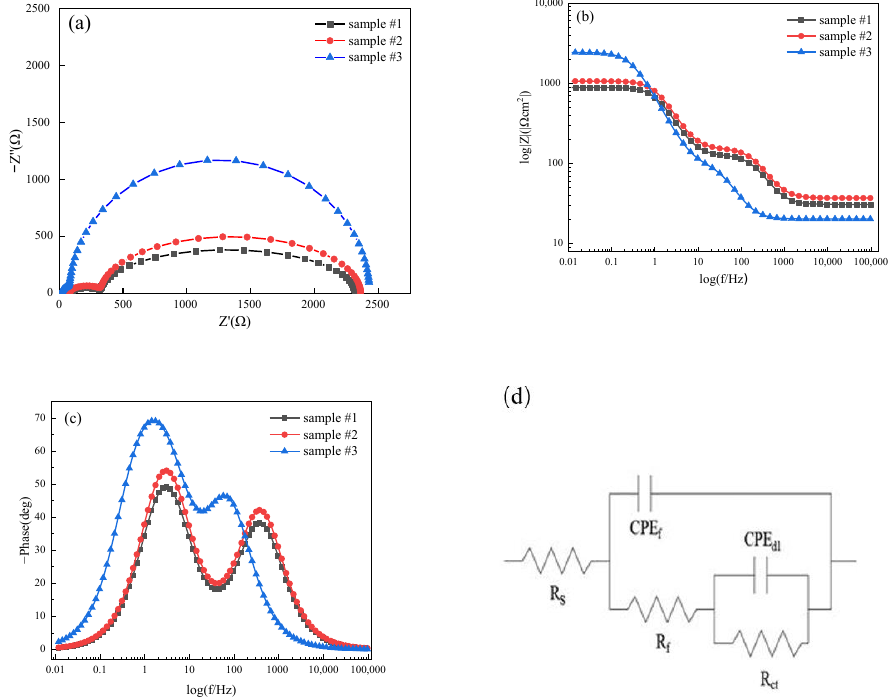
Figure 10. Electrochemical impedance spectra of the weld joints under different welding currents( a ) Nyquist plots, ( b ) impedance bode diagrams ( c ) phase angle, and ( d ) equivalent circuit diagram. Table 5. Equivalent circuit parameters.